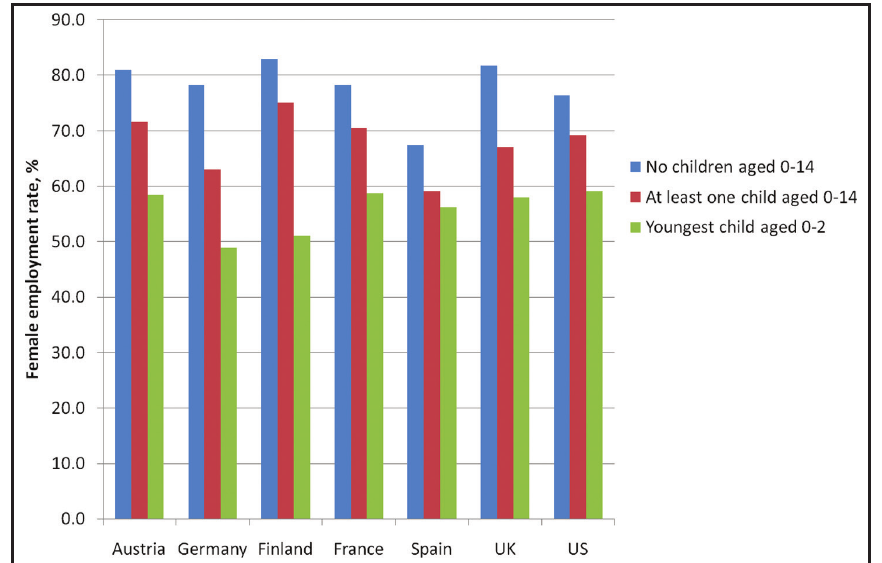
Employment rates of females aged 25–54 years by age of the youngest child,